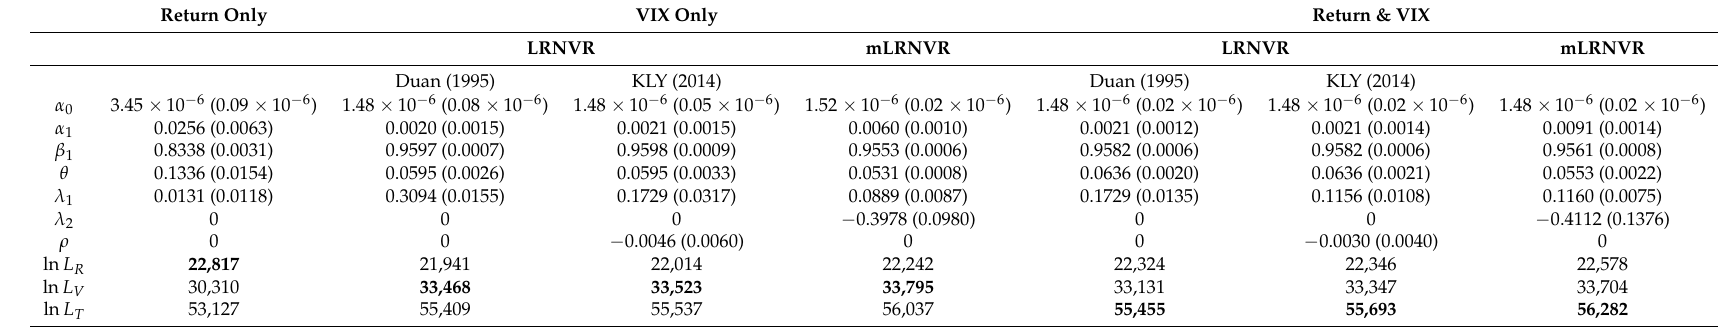
Table 2. Maximum likelihood estimates of TGARCH(1,1) model using returns data only, VIX data only or both returns and VIX data. The bold values indicate the log-likelihood value which is being maximized. The standard errors are provided in parentheses. We use a sample of 6928 daily data for the model estimation. Return Only VIX Only Return & VIX LRNVR mLRNVR LRNVR mLRNVR Duan (1995)